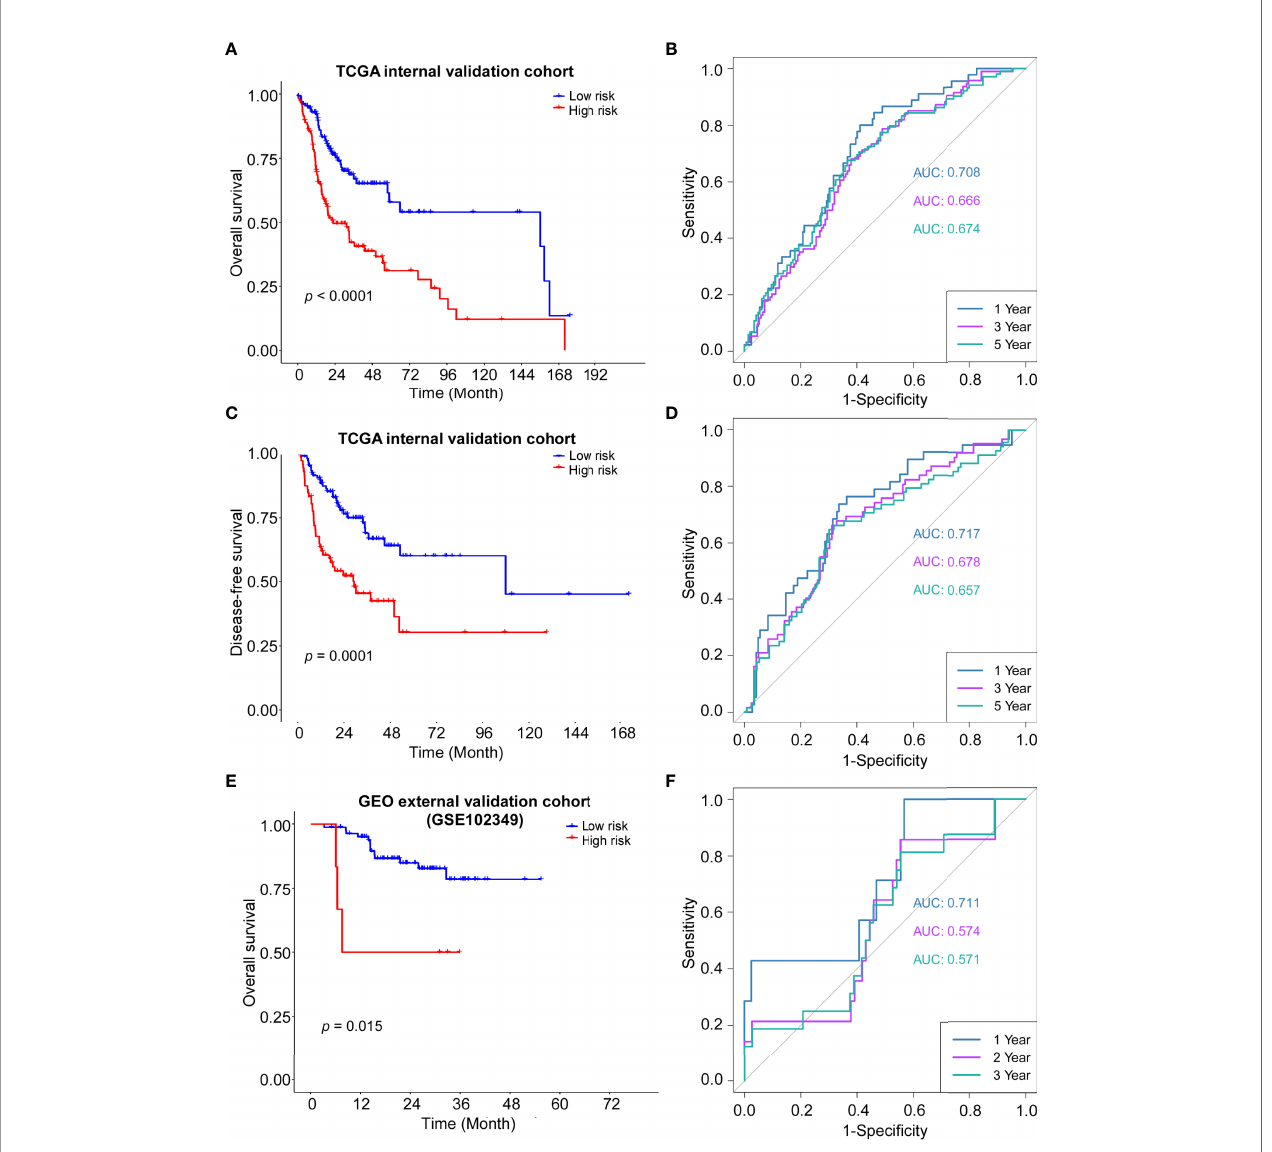
FIGURE 4 | Validation of the ADME gene signature in the internal and external cohort. (A) Kaplan – Meier curves for the OS of high-risk and low-risk groups in the internal cohort. Log-rank test, P <0.0001. (B) Time-dependent ROC curve of risk score in internal cohort on OS. (C) Kaplan – Meier curves for the DFS of high-risk and low-risk groups in the internal cohort. Log-rank test, P=0.0001. (D) Time-dependent ROC curve of risk score in internal cohort on DFS. (E) Kaplan – Meier curves for the OS of high-risk and low-risk groups in the GSE102349 cohort. Log-rank test, P=0.0015. (F) Time-dependent ROC curve of risk score in GSE102349 cohort on